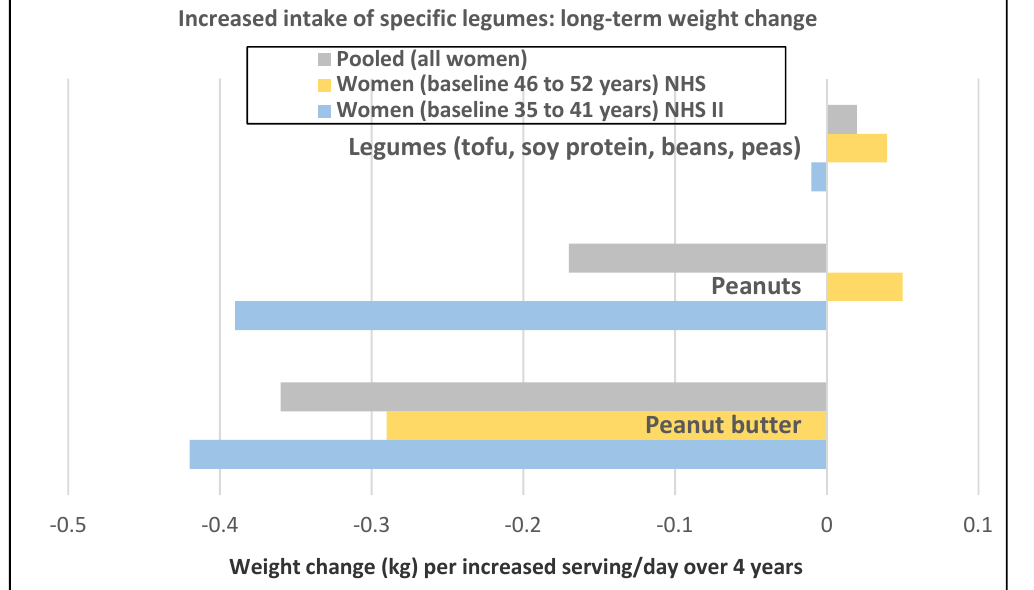
Figure 5. Multivariate adjusted association from 94,922 women in the Nurses’ Health Studies (NHS) per increased serving/day of legumes and 4-year weight change (kg) in women of different age groups [19].